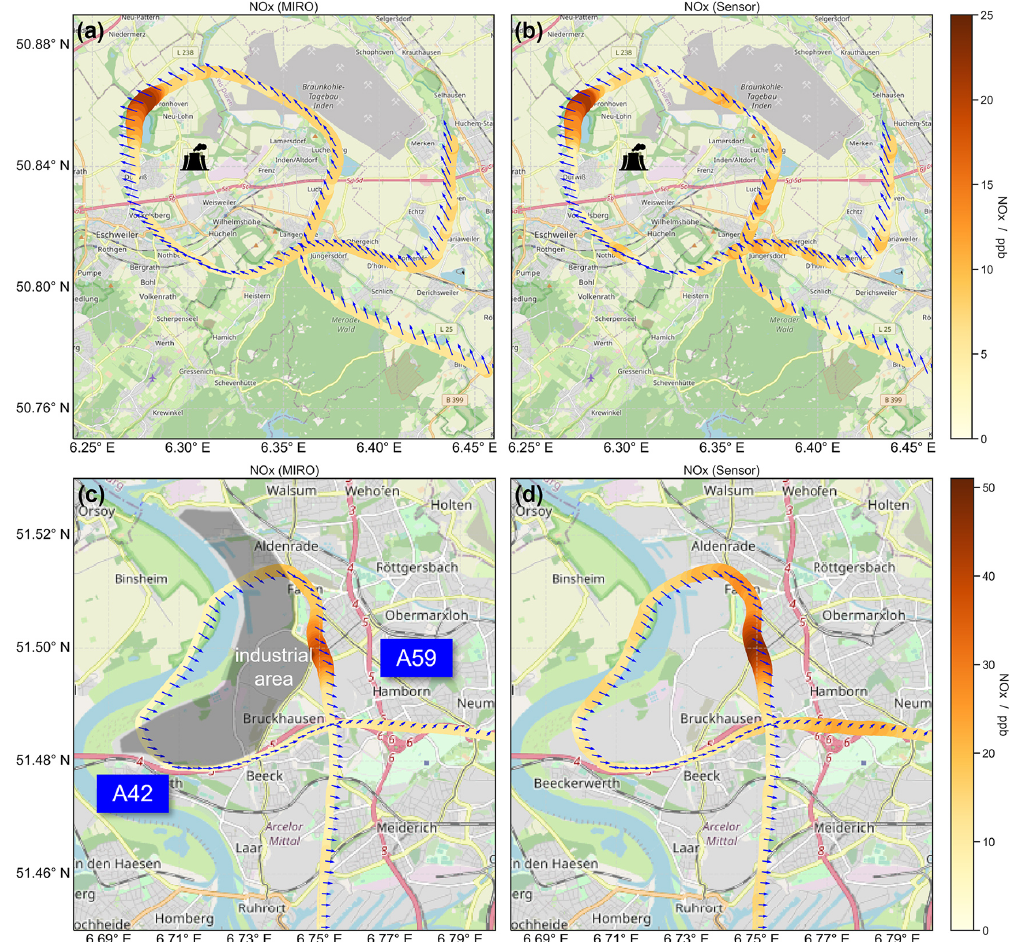
Figure 6. Amount fractions of NO x are shown by color and size for the MIRO MGA (a, c) and the corrected sensor data of setup no. 2 (b, d) during flights in North Rhine-Westphalia, Germany, near and in the cities of Eschweiler and Duisburg, respectively (©OpenStreetMap contributors 2022. Distributed under the Open Data Commons Open Database License (ODbL) v1.0). The orientation and length of the arrow indicate the wind direction and wind speed (2.1 to 7.2ms − 1 for panels a and b and 1.0 to 2.6ms − 1 for panels c and d ; data from EURAD-IM, WRF), respectively. With this, the emission sources can be narrowed down to a lignite-fired power plant located southeast of the detected peak (a, b) and to a steel industry (c, d) located in the gray shaded